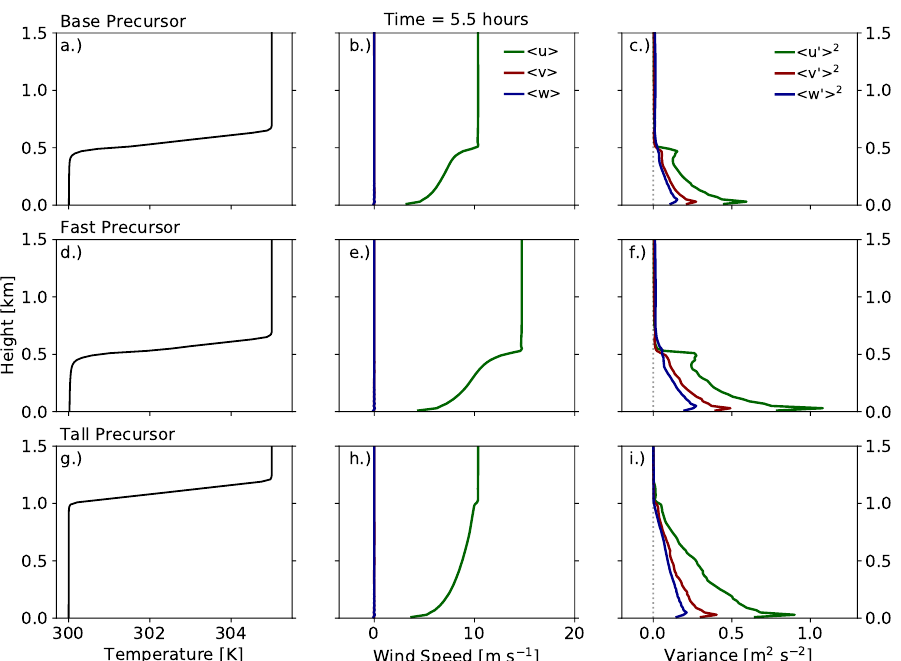
Figure 3. Domain average profiles of potential temperature ( a , d , g ), the three components of wind speed ( b , e , h ), and the variance of the three components of wind speed ( c , f , i ) for the Base precursor ( a – c ), Fast precursor ( d – f ), and Tall precursor ( g – i